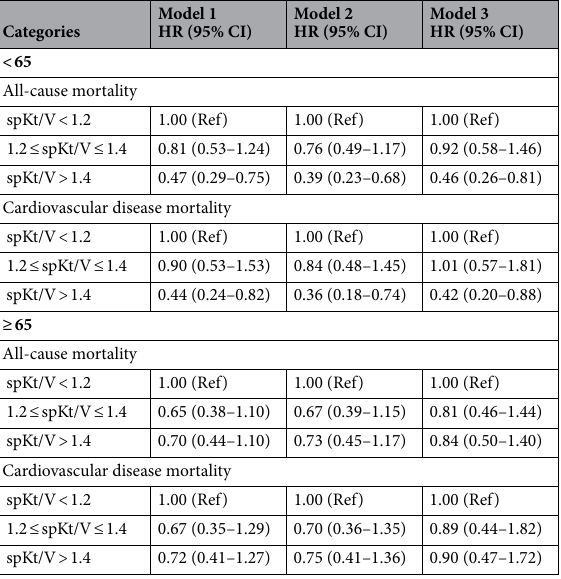
Table 3. Hazard ratios (95% CI) for the association between dialysis dose and all-cause and cardiovascular disease mortality by age. CI confidence interval, HR hazards ratio, Ref reference. a Model 1: Crude model. b Model 2: Adjusted for gender and duration of dialysis. c Model 3: Adjusted for gender, duration of dialysis, heart failure, hemoglobin, albumin, creatinine, total cholesterol and primary